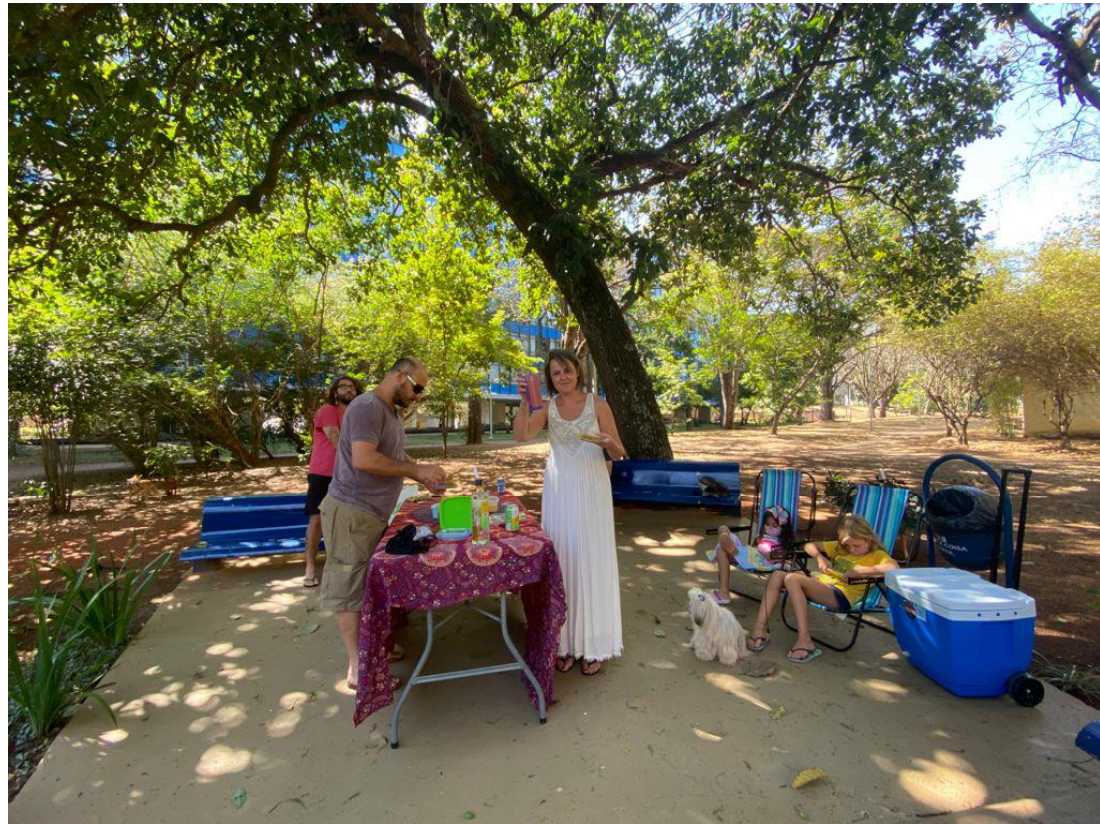
Figure 9: Superquadra 'new normal': celebrating birthdays on public spaces. (Photo credit: Virginia Manfrinato, 2021)